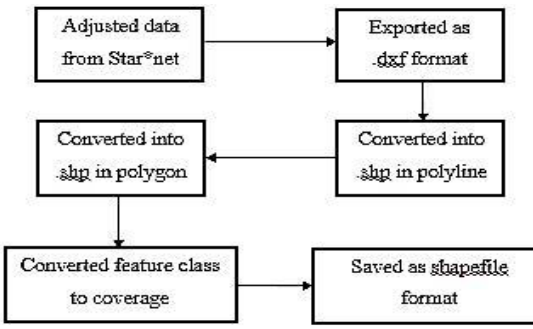
Figure 6. Accurate cadastral database